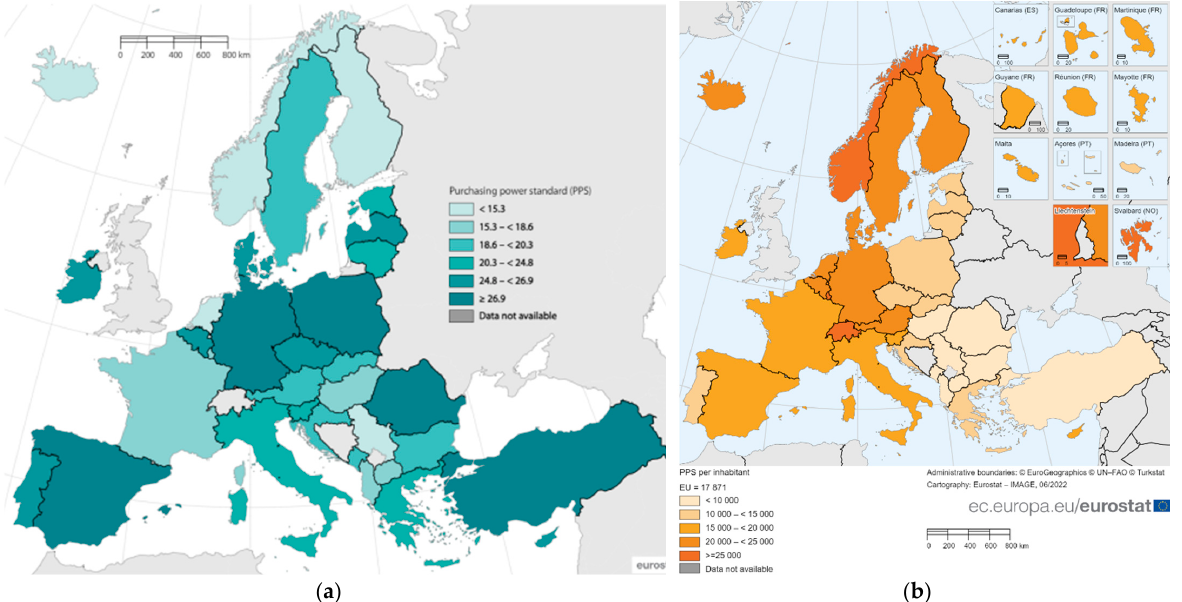
Figure 7. ( a ) Electricity prices for household consumers (2021) and ( b ) Median Disposable Income, across Europe (adapted from [82,83]).